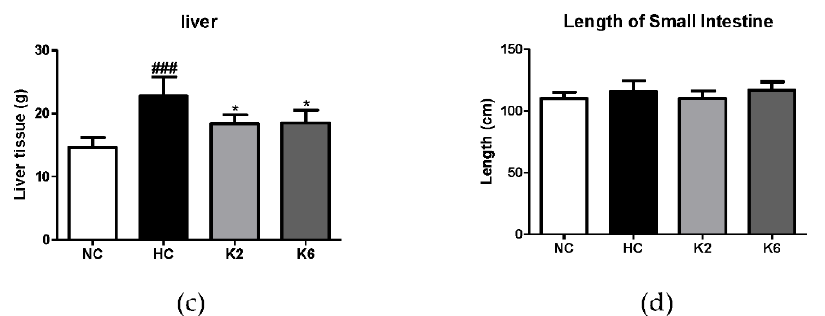
Figure 1. Effect of L. plantarum treatments on organ weight and small intestine length. Visceral fat ( a ) and epididymal fat ( b ) were evaluated for weight and size. Liver tissue ( c ) was also evaluated for weight and small intestine ( d ) for length. Values represent the mean ± SEM. # p < 0.05, ## p < 0.01, and ### p < 0.001 vs. control group (NC), * p < 0.05 vs. HC group. NC, normal diet control; HC, HFHF diet control; K2, HFHF diet with K2; K6, HFHF diet with K6.